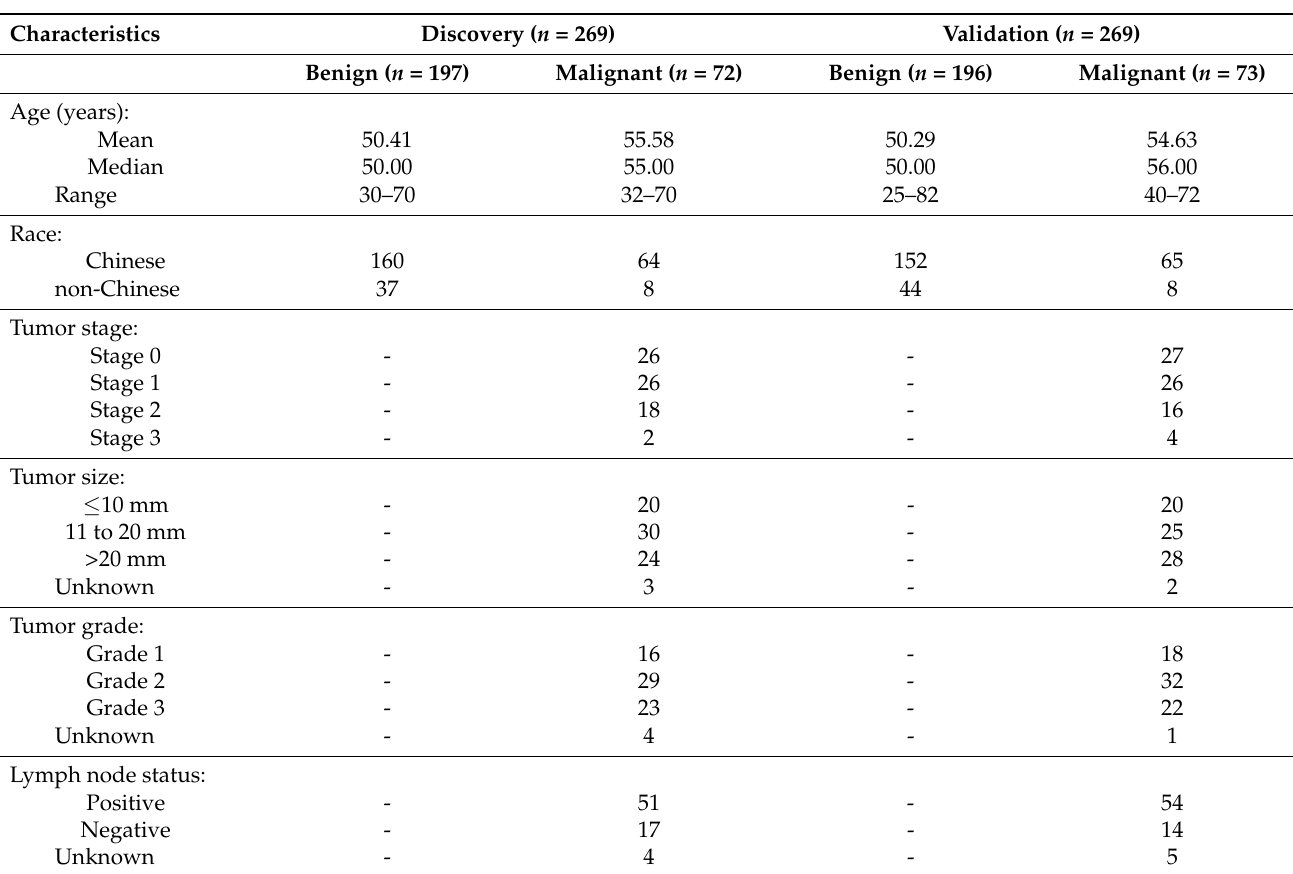
Table 1. Clinicopathological characteristics of patient